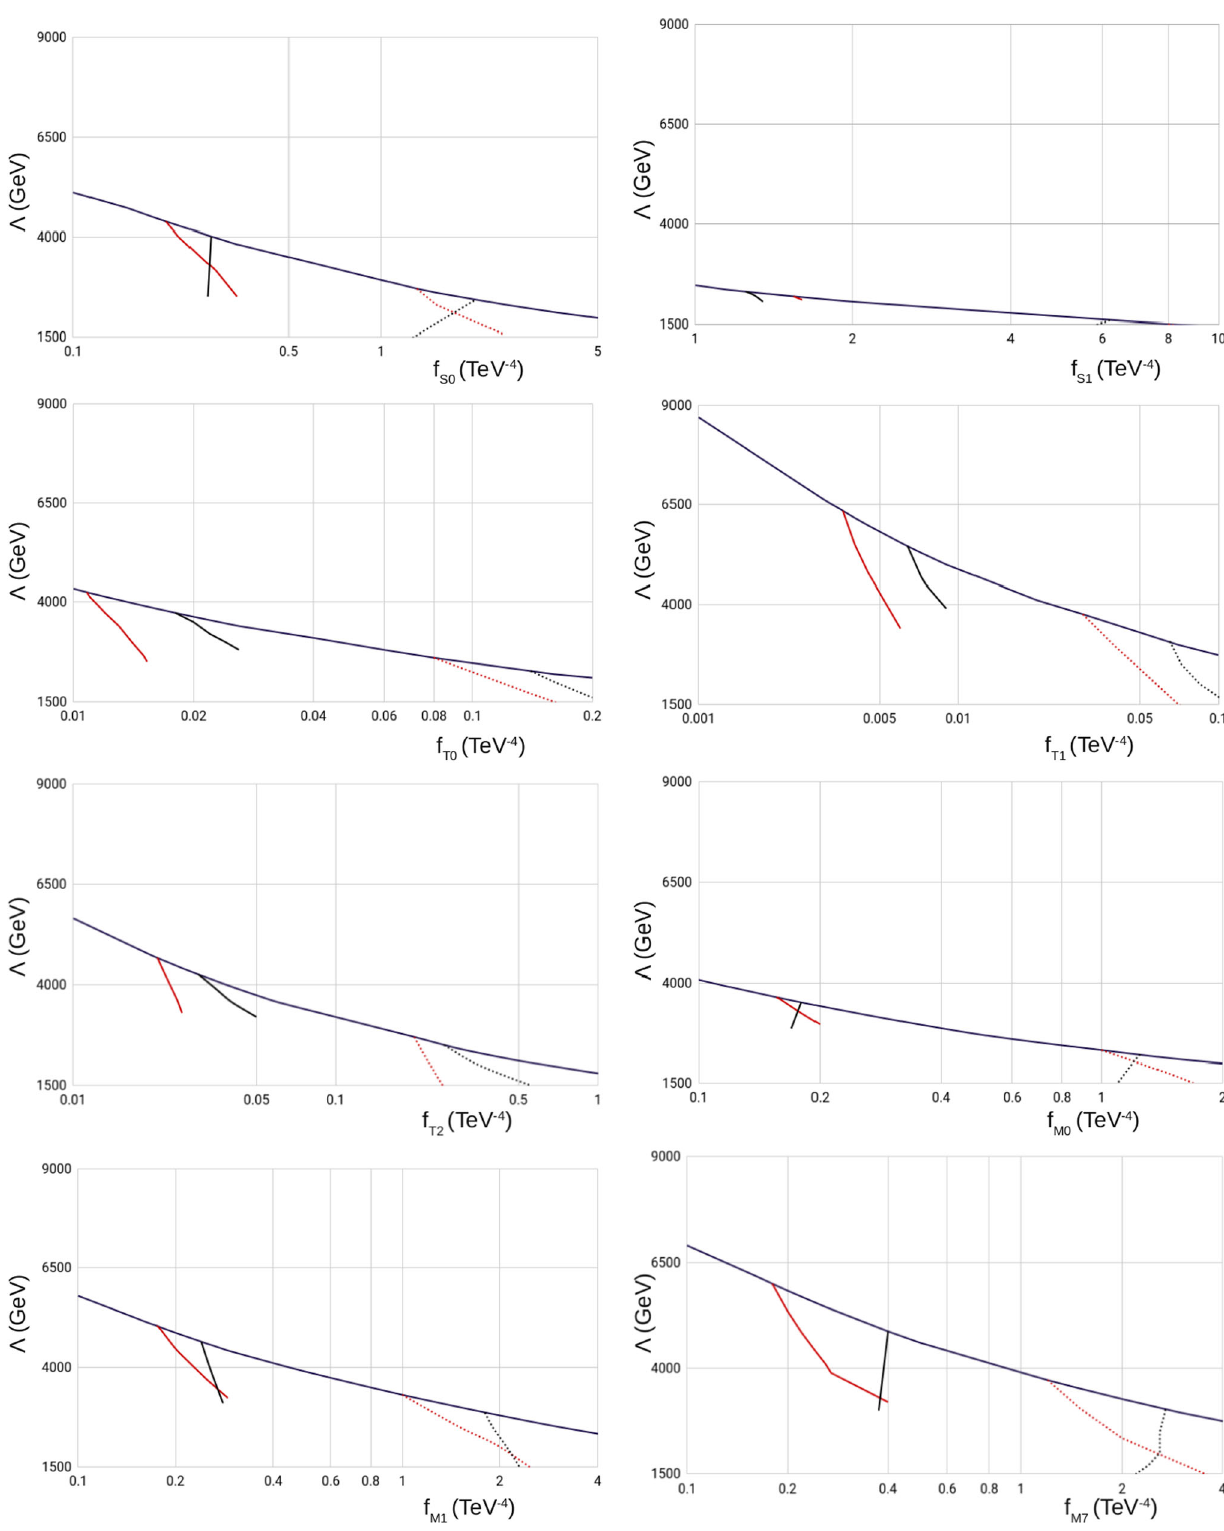
Fig. 2 Regions in the (cid:2) vs f (positive f values) space for dimension- 8 operators in which a 5 σ BSM signal can be observed and the EFT is applicable. The unitarity limit is shown in blue; the lower limits